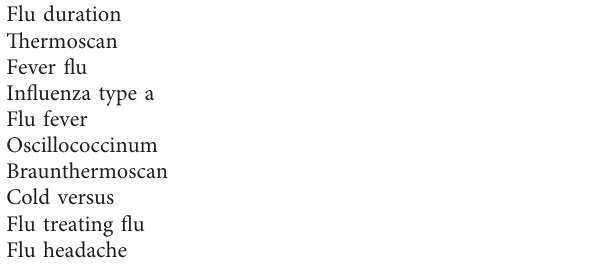
Table 1: Most significant 10 Google search